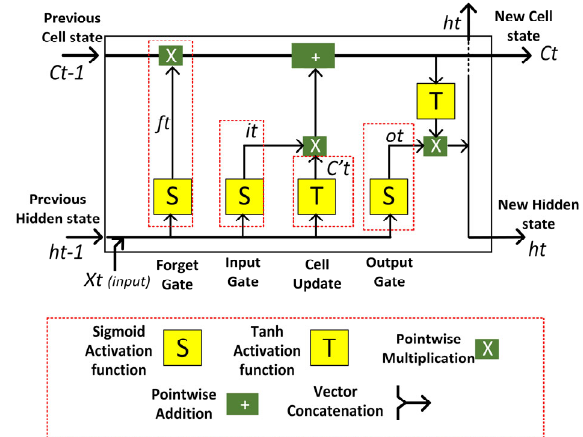
Figure 1. The architecture of LSTM